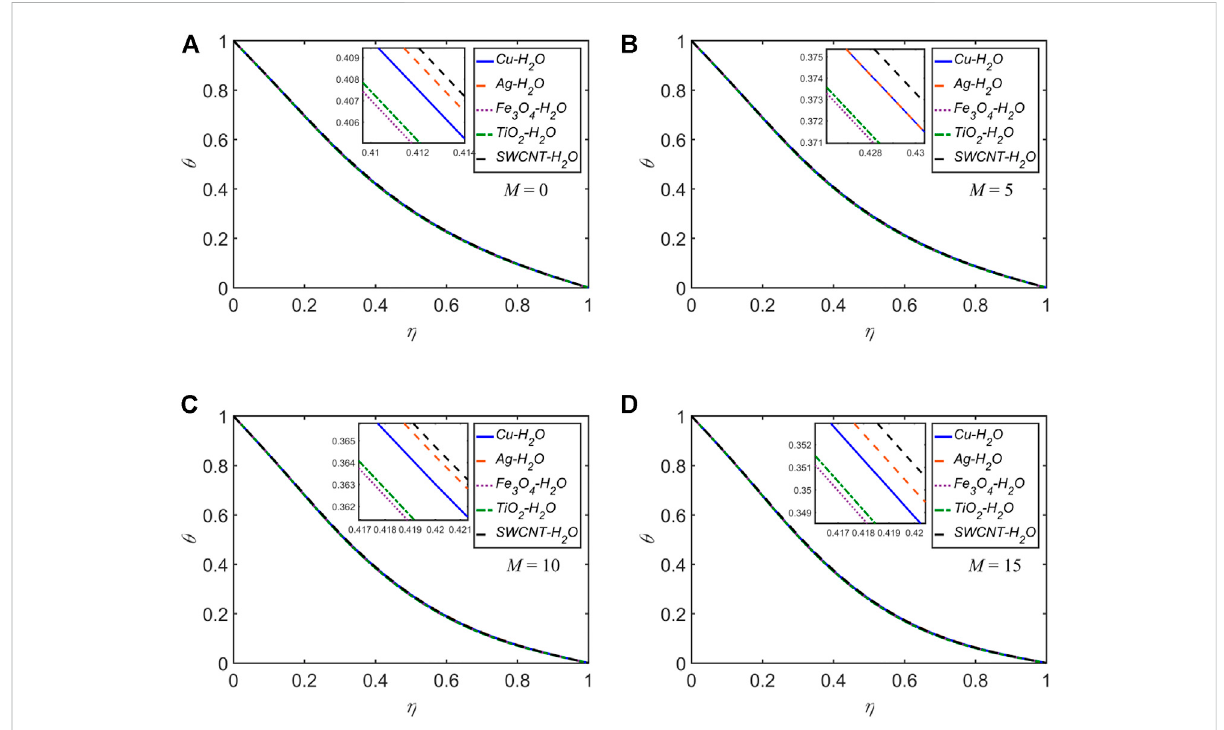
The temperature pro fi le θ versus η at x (cid:2) 0 and t (cid:2) 0 . 25 for the fi ve NFs for distinct values of M